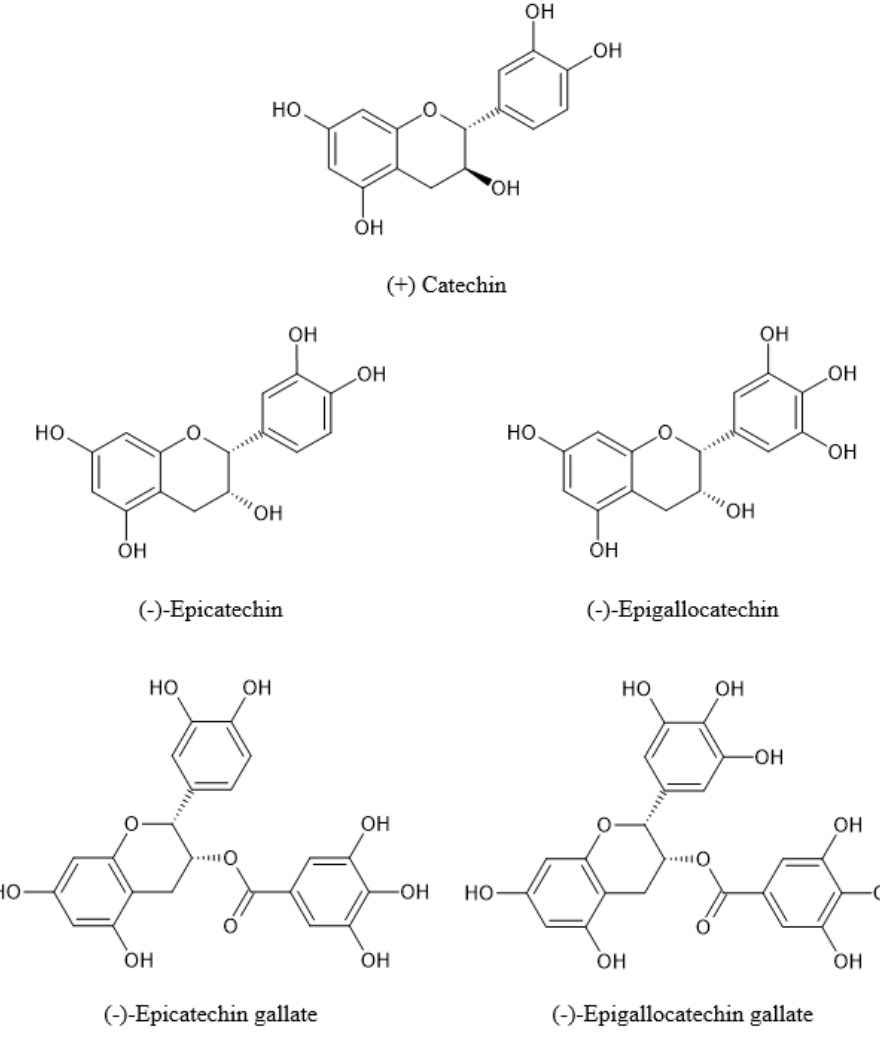
Figure 3. Structure of the main types of catechins found in the leaves of E. guineensis .